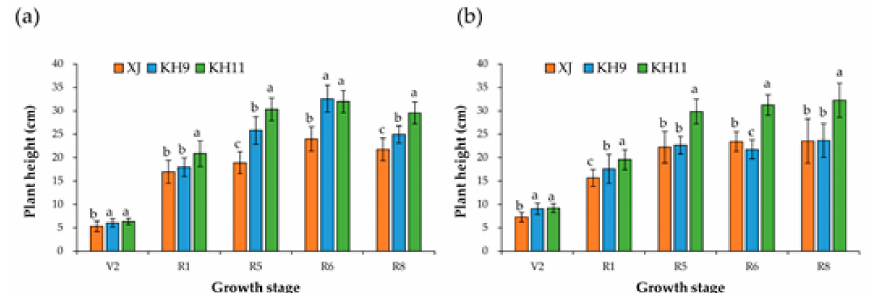
Figure 2. Plant heights of edamame cultivars at different growth stages in 2017 ( a ) and 2018 ( b ). Values represent the mean ± SD of at least three biologically independent experiments (N ≥ 3, n = 16). Different letters indicate significant differences between cultivars assessed using the LSD post hoc test ( p < 0.05). XJ, Xiang-Ji. KH9, Kaohsiung No. 9. KH11, Kaohsiung No. 11. V2, vegetative stage 2.